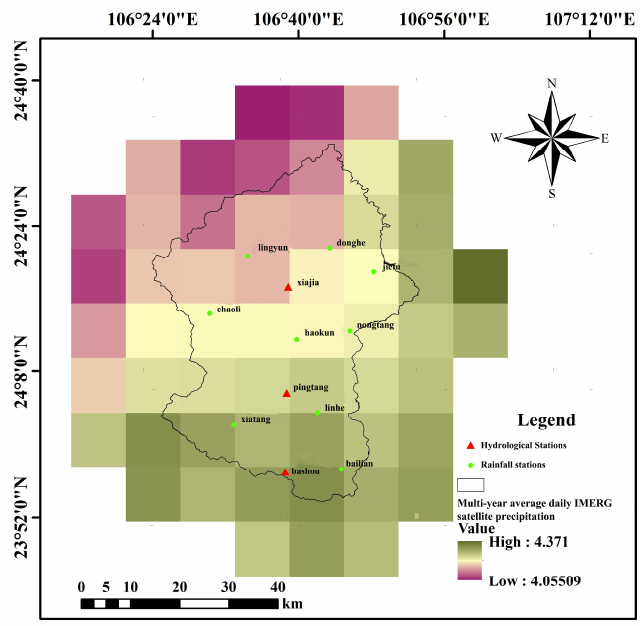
Figure 4. Multi-year average daily rainfall of the IMERG satellite.